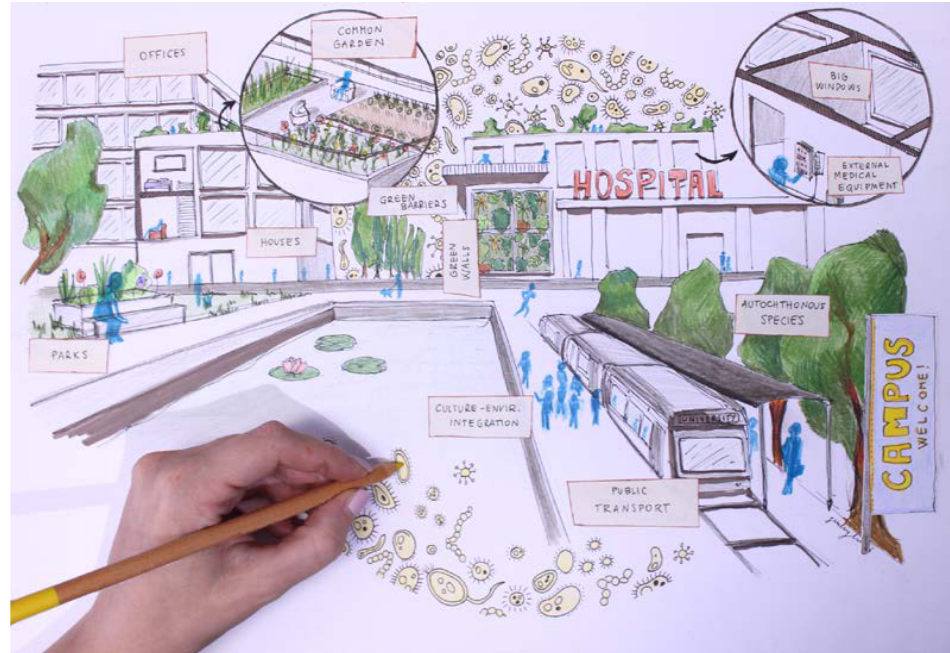
Figure 2. The new “Urban”: Projects regarding future everyday life hot-spots is something that must be done today; in the illustration, a hand is indeed drawing the vision for a new meaning of infrastructure. The key themes are functions integration and social inclusion through bioinformed design and architecture. The same spaces have multiple functions. The park becomes a recreational (but also educational) area of a university campus underlying the imperative role of knowledge in re-modelling the environment. Public transportation lines are surrounded by trees, vegetation, and natural elements such as ponds and gardens, so that autochthonous species become reintegrated. Houses and workplaces are designed to be well-lit environments, with direct access to nature thanks to the presence of terraces and common gardens (that also favor socializing and manual activities such as gardening and horticulture). Architectural elements, such as acoustic barriers and structural walls, are implemented along with green-promoting elements. Lastly, hospitals are re-designed to promote physical and mental health via lighter and greener accessible areas, on one hand, and via the reduction in the transmission of possible pathogenic microorganisms (isolating patients from commonly touched medical equipment). The microbiota is represented as the human–health–environment linking element.